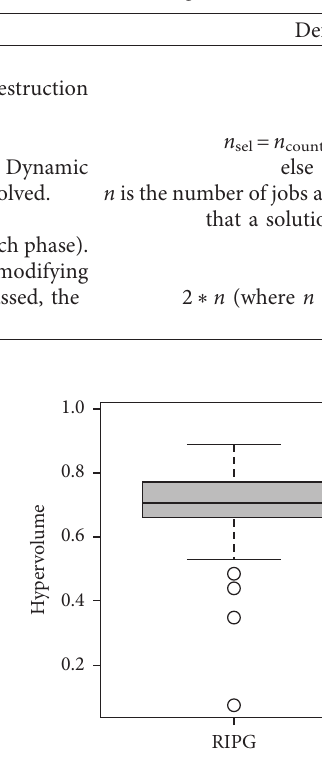
Figure 3: Box plot showing hypervolume in a biobjective environment.